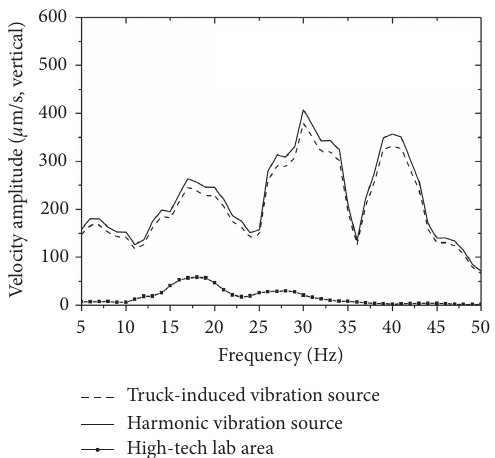
Figure 14: Ground vibrations at the vibration source area and high-tech lab area.